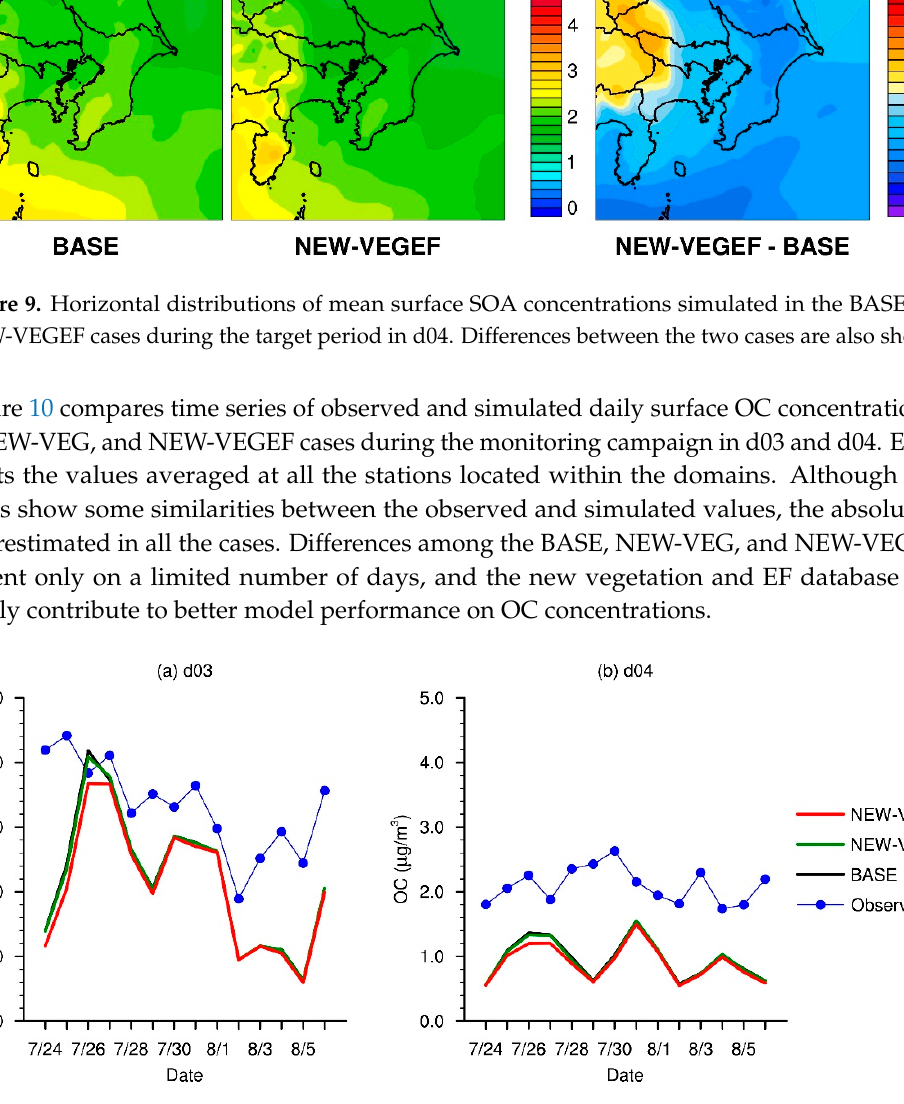
Table 5. Statistical analysis of model performance for daily surface OC concentrations during the monitoring campaign in d03 and d04.